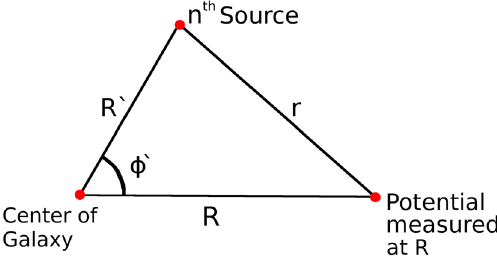
Fig. 1 For a position with radius R , the relative distances of an n th source are shown, where the radius of the source is denoted by R (cid:8) , and the r represents the distance between the source and the position where the potential is being measured. All distances are in cylindrical